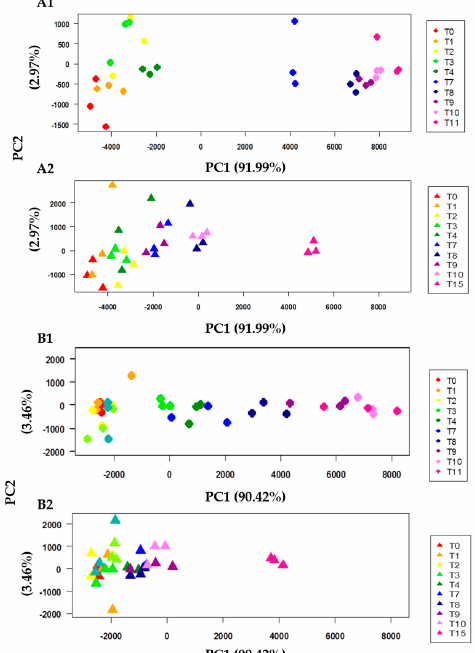
Figure 5. PCA scores plot of spectra data set. ( A1 ) Red mullet ( Mullus barbatus ) and ( B1 ) bogue ( Boops boops ) samples at +4 °C, and ( A2 ) red mullet ( Mullus barbatus ) and ( B2 ) bogue ( Boops boops ) samples at 0 °C. The PC models and graphs were calculated using the R program.